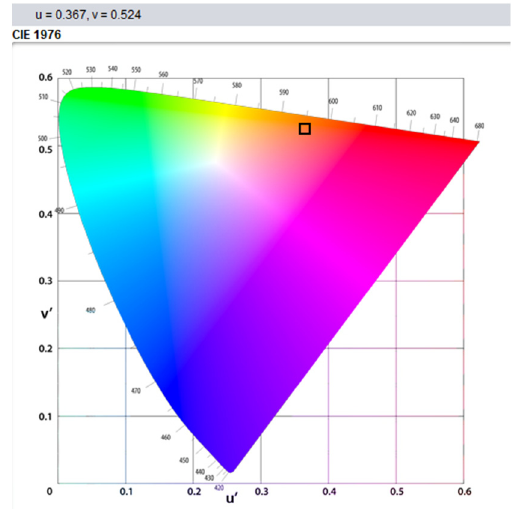
Figure 8. The emission profile of Eu:BGO as expressed in CIE 1976 color space.